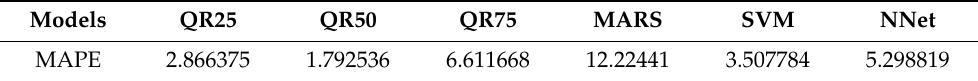
Table 9. MAPE of ROI for Year 2015 with 2010–2014 Years data (out of sample forecast).